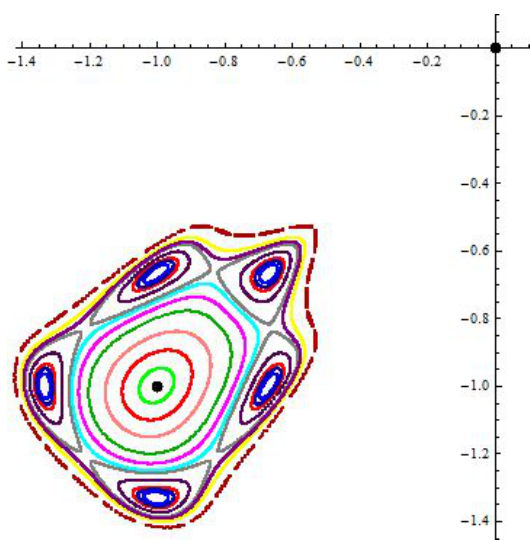
Figure 7. S.P.O. around the elliptic equilibrium ( − 1, − 1 ) for α = 3.5 and β =